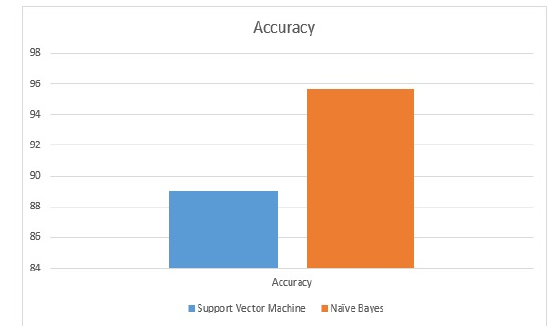
Fig. 17: Accuracy of Naïve Bayes and